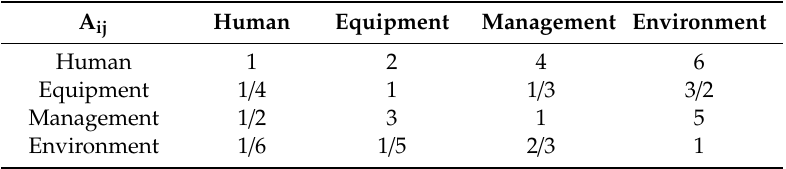
Table 2. Comparison matrix of risk level of system.